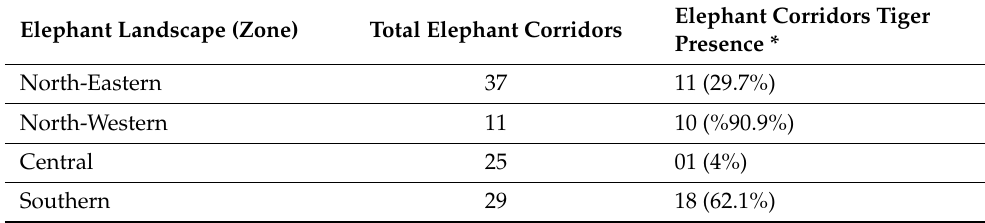
Table 3. Details of tiger presences in elephant corridors (* see Appendix A for further details). Elephant Landscape